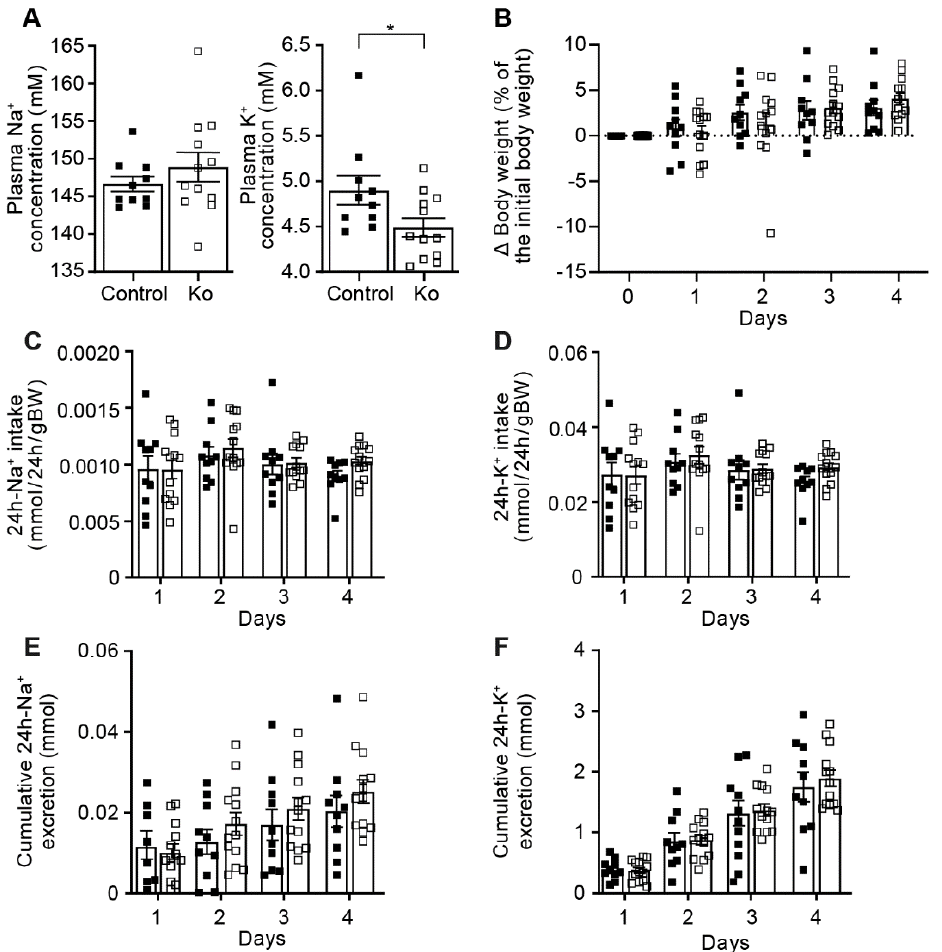
Figure 3. Prss8 PaxLC1 (knockout) mice displayed normal Na + but significantly altered K + handling under low Na + diet. ( A ) Plasma Na + (left) and K + concentrations (right) in control (black) and knockout (white square) mice. ( B ) Body weight changes (expressed as percent of initial body weight), ( C ) 24 h Na + and ( D ) K + intake and ( E ) 24 h cumulative Na + and ( F ) K + excretion (mmol/24 h/gBW; control, n = 9–10; Ko, n = 13). Results are presented as mean ± SEM (2 series of experiments, control n = 10, knockout n = 12). ( A ) was analyzed by an unpaired two-tailed t test, ( B – F ) by a multiple t -test. p values < 0.05 were considered statistically significant. * p < 0.05.